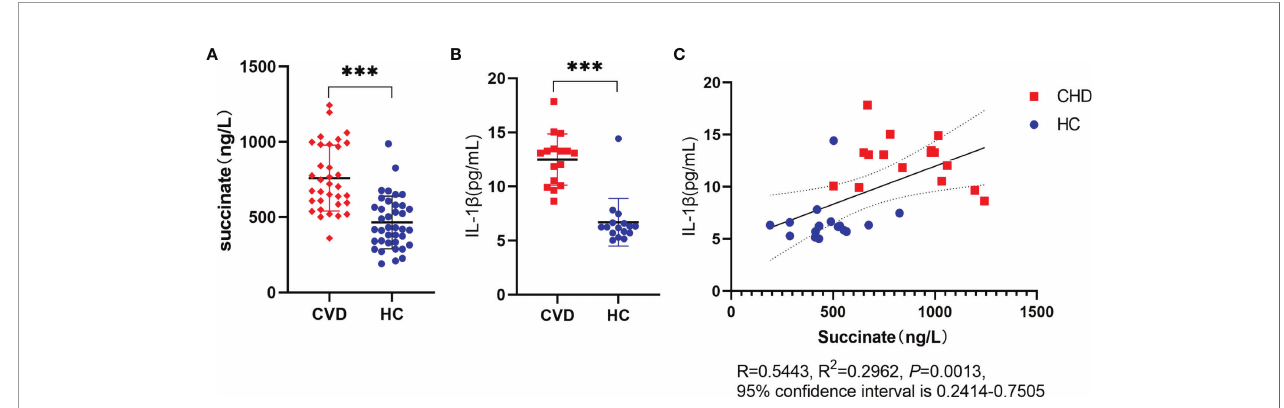
FIGURE 1 | Expression of succinate and IL-1 b in CHD. Radial arterial blood is collected before coronary angiography, then volunteers are divided into CHD group and HC group based on the results of coronary arteriostenosis. (A, B) Succinate and IL-1 b were assessed via ELISA. Succinate detection (CHD group, n = 34; HC group, n = 38), IL-1 b detection (CHD group, n = 16; HC group, n = 16), and all samples of this section had succinate detection. (C) Clinical correlation was analyzed in human samples using Pearson ’ s correlation coef fi cient (R = 0.5443, R 2 = 0.2962, P = 0.0013, 95% con fi dence interval is 0.2414 – 0.7505). ***P <